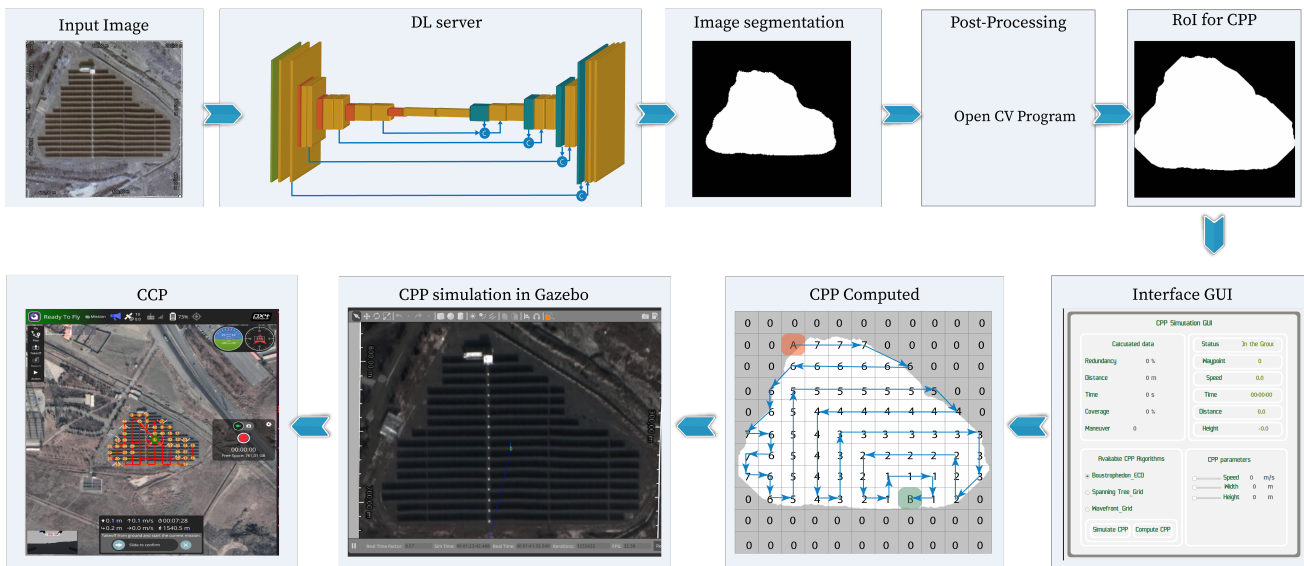
Figure 1. Stages for CPP with semantic segmentation for UAV in PV